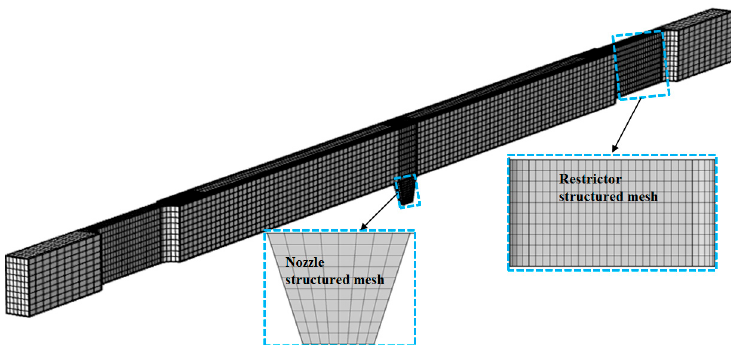
Figure 4. Meshed 3D model of half of the proposed recirculating inkjet printhead.